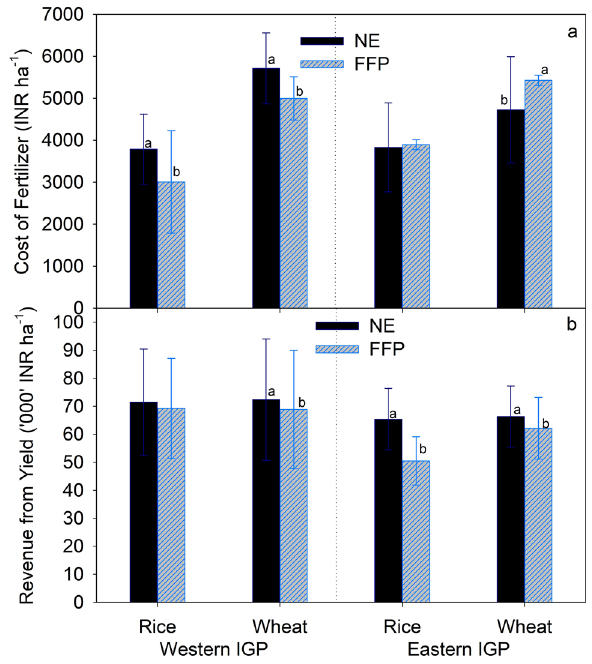
Figure 5. Cost of fertilizer and income from yield in rice and wheat production under Nutrient Expert (NE) and Farmers’ Fertilizer Practice (FFP) in the study areas. Values are average of all the comparison trials over the study period. Within each pair, bars bearing different lowercase letters are significantly different from each other based on paired t-test (p = 0.05). Error bar shows standard deviation. IGP = Indo-Gangetic